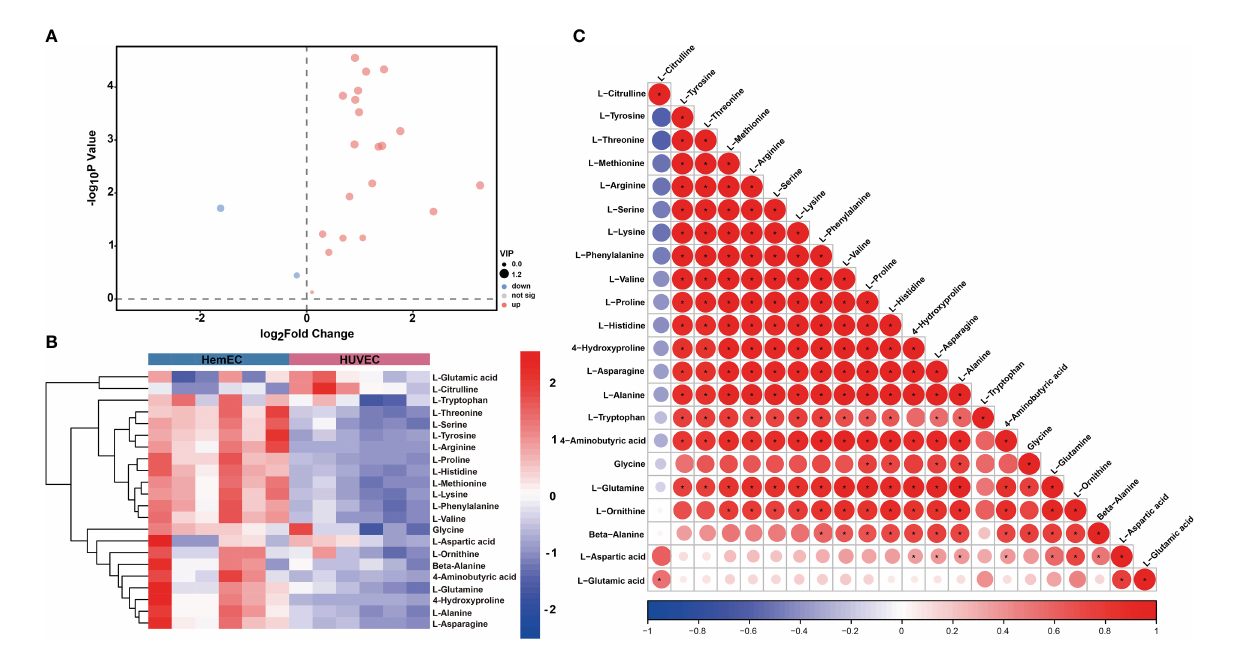
FIGURE 6 Differential metabolites (DMs) between HUVECs and HemECs by targeted metabolic analysis. (A) Volcano plot analysis of DMs with VIP value > 1 and P value <0.05. (B) Heatmap of hierarchical cluster analysis of 22 DMs. (C) Correlation analysis of 22 differential amino acids. The color of each line represents the Pearson correlation coef fi cient of two differential metabolites. Red indicates a positive correlation, and blue indicates a negative correlation. *represents signi fi cance. P < 0.05.